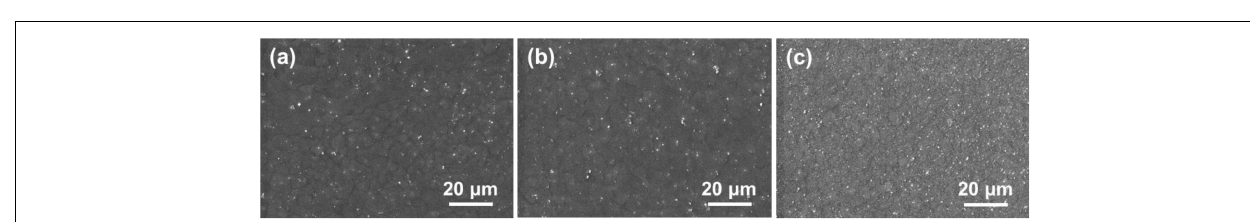
FIGURE 5 | SEM micrographs of SZ-center in FSPed AZ31/ZrO 2 composites: (a) Z1-3P specimen, (b) Z2-3P specimen, and (c) Z3-3P specimen.